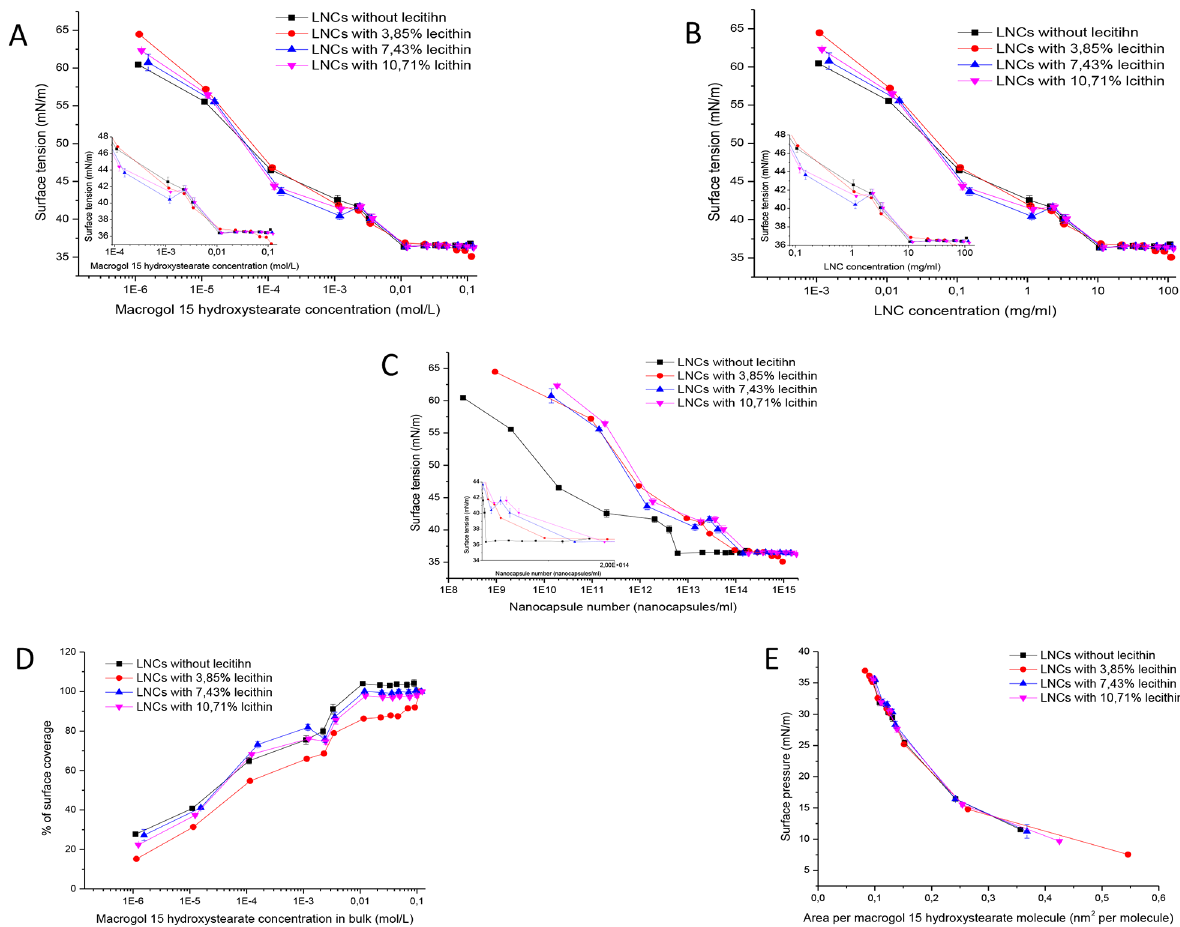
Fig 5. Surface tensionas a function of MHS concentration (A) LNC concentration, (B) nanocapsule number, (C) surface coverage percentageas a function of MHS concentration, (D) surface pressure versus area per MHS moleculeand (E) LNC formulations containingdifferent quantitiesof lecithin as determined by the Wilhelmy plate